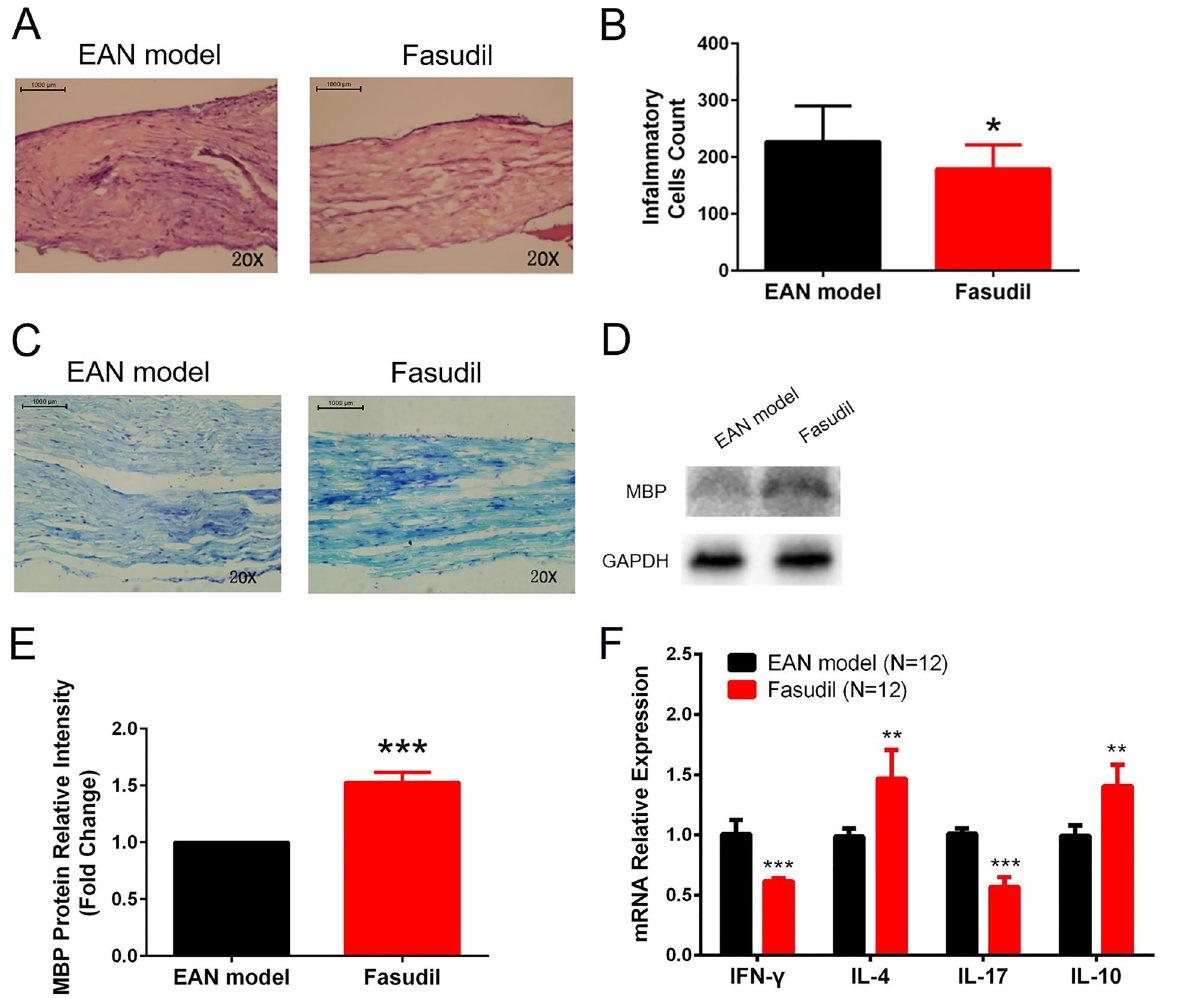
Figure 2. Sciatic nerves in fl ammation and demyelination in experimental autoimmune neuritis (EAN) mice treated or not with fasudil. Fasudil decreased in fl ammatory cell in fi ltration in sciatic nerves ( A and B ), and attenuated sciatic nerves demyelination at Day 28 ( C ). Scale bars: 1000 m m. D and E , Fasudil increased sciatic nerves anti-myelin basic protein (MBP) expression at day 28. F , Fasudil decreased interferon (IFN)- g and interleukin (IL)-17 mRNA expressions and increased IL-4 and IL-10 mRNA expressions at day 28. Data are reported as mean and SD. *P o 0.05, **P o 0.01, ***P o 0.001 compared to the EAN model ( t